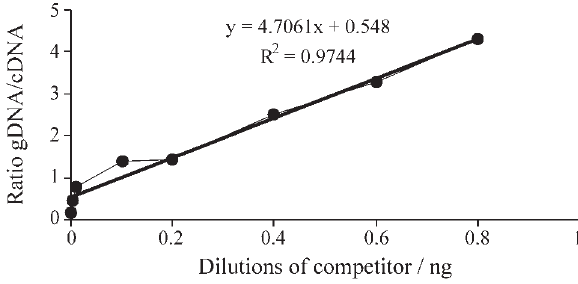
Figure 9 - Plotted gDNA/cDNA ratio after amplification, versus competi- tor dilutions added to mixture (0.8 ng, 0.6 ng, 0.4 ng, 0.2 ng, 0.1 ng, 0.01 ng, 0.005 ng, and 0.001 ng), and regression equation.